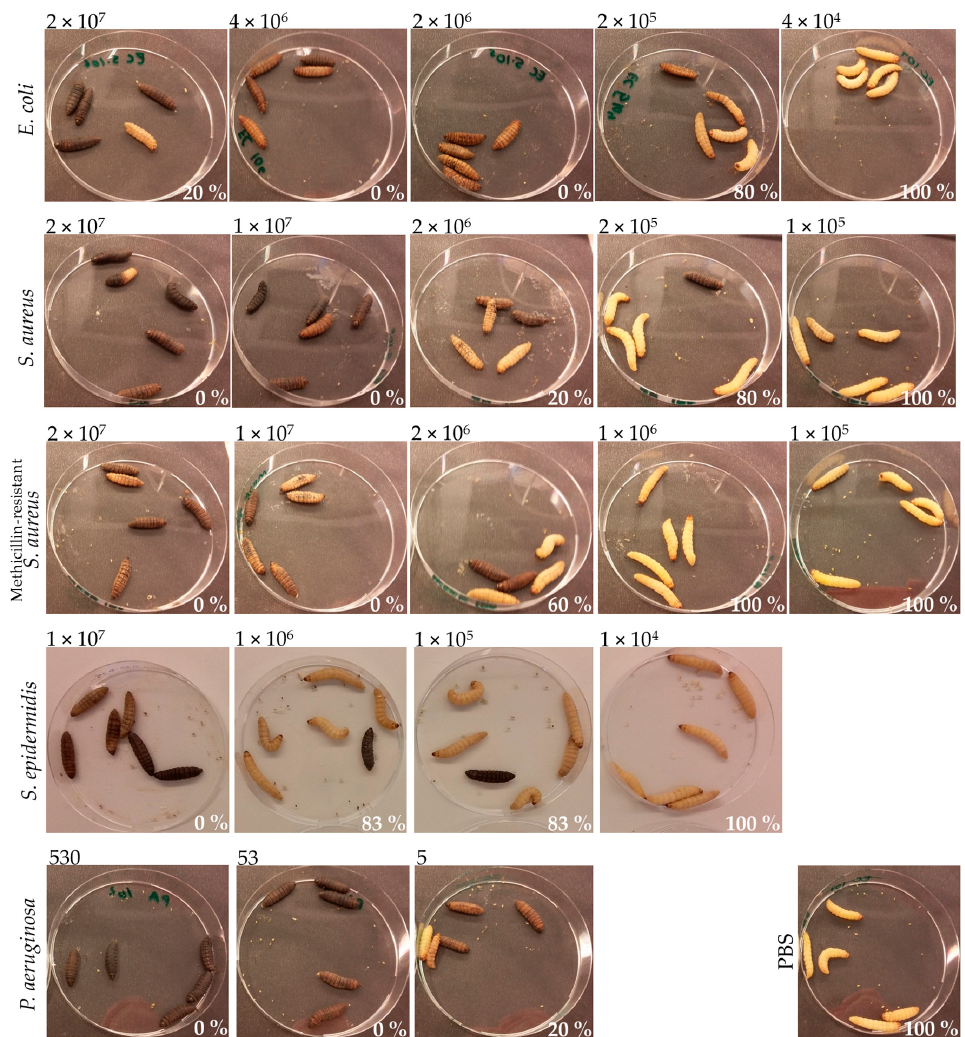
Figure 4. Pathogenicity of different bacterial species in G. mellonella larvae at 24 h post-infection. Larvae ( n = 5–6) were infected with decreasing concentrations of each of the following